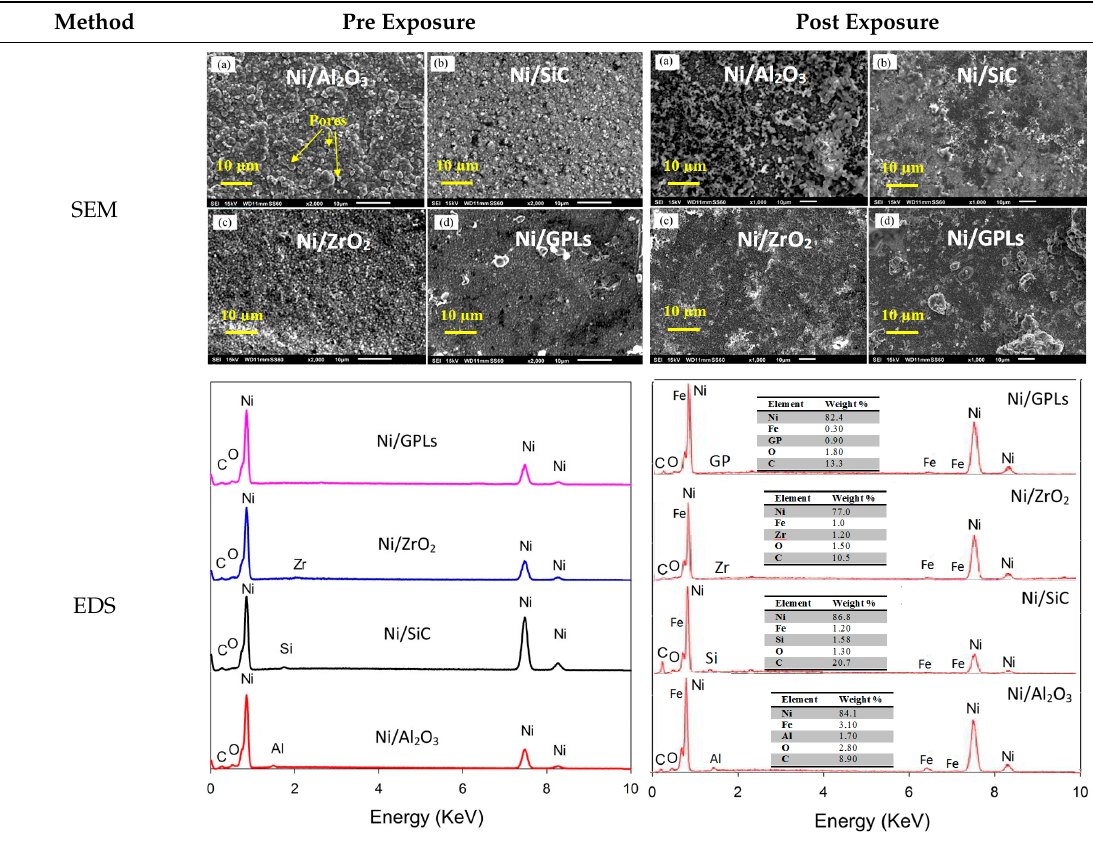
Table 1. Pre- and Post-exposure surface morphology results.